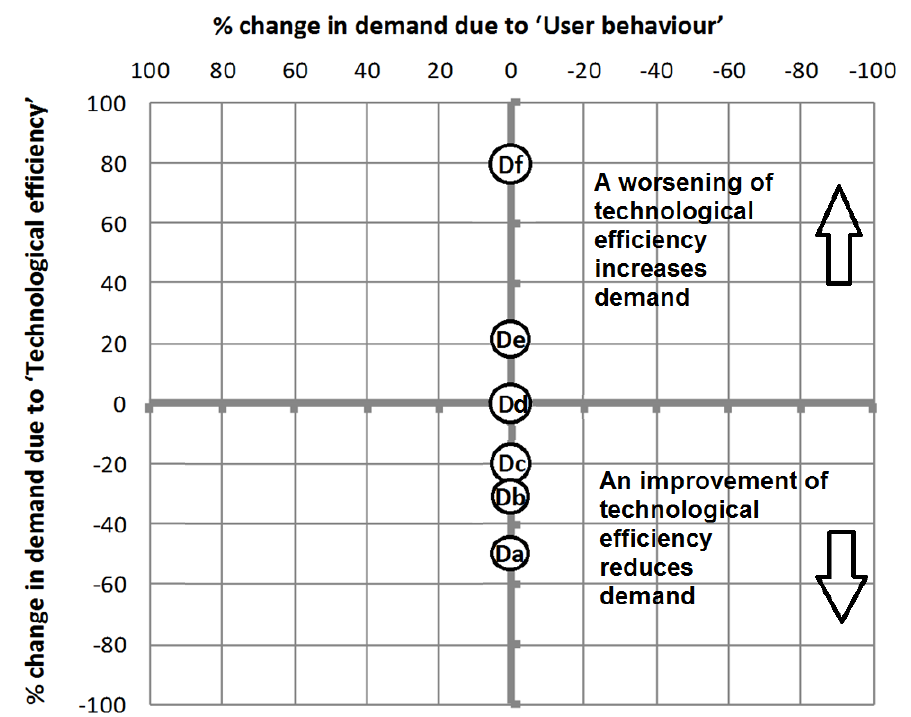
Figure 3. Domestic demands through technological change (Futures Framework